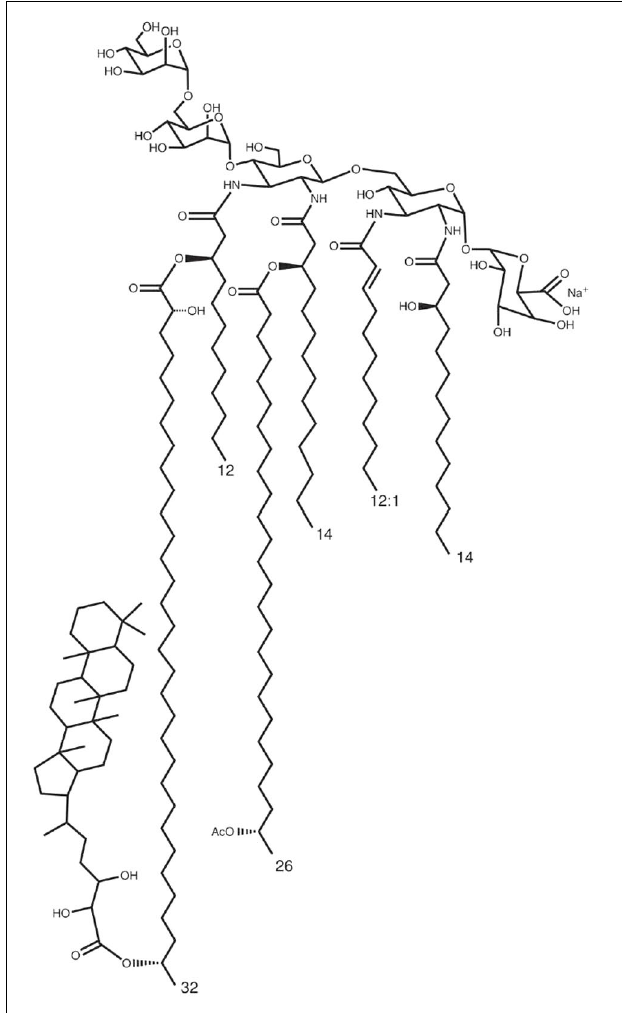
FIGURE 1 | Bradyrhizobium BTAi1 lipid A structure (Silipo et al., 2014).